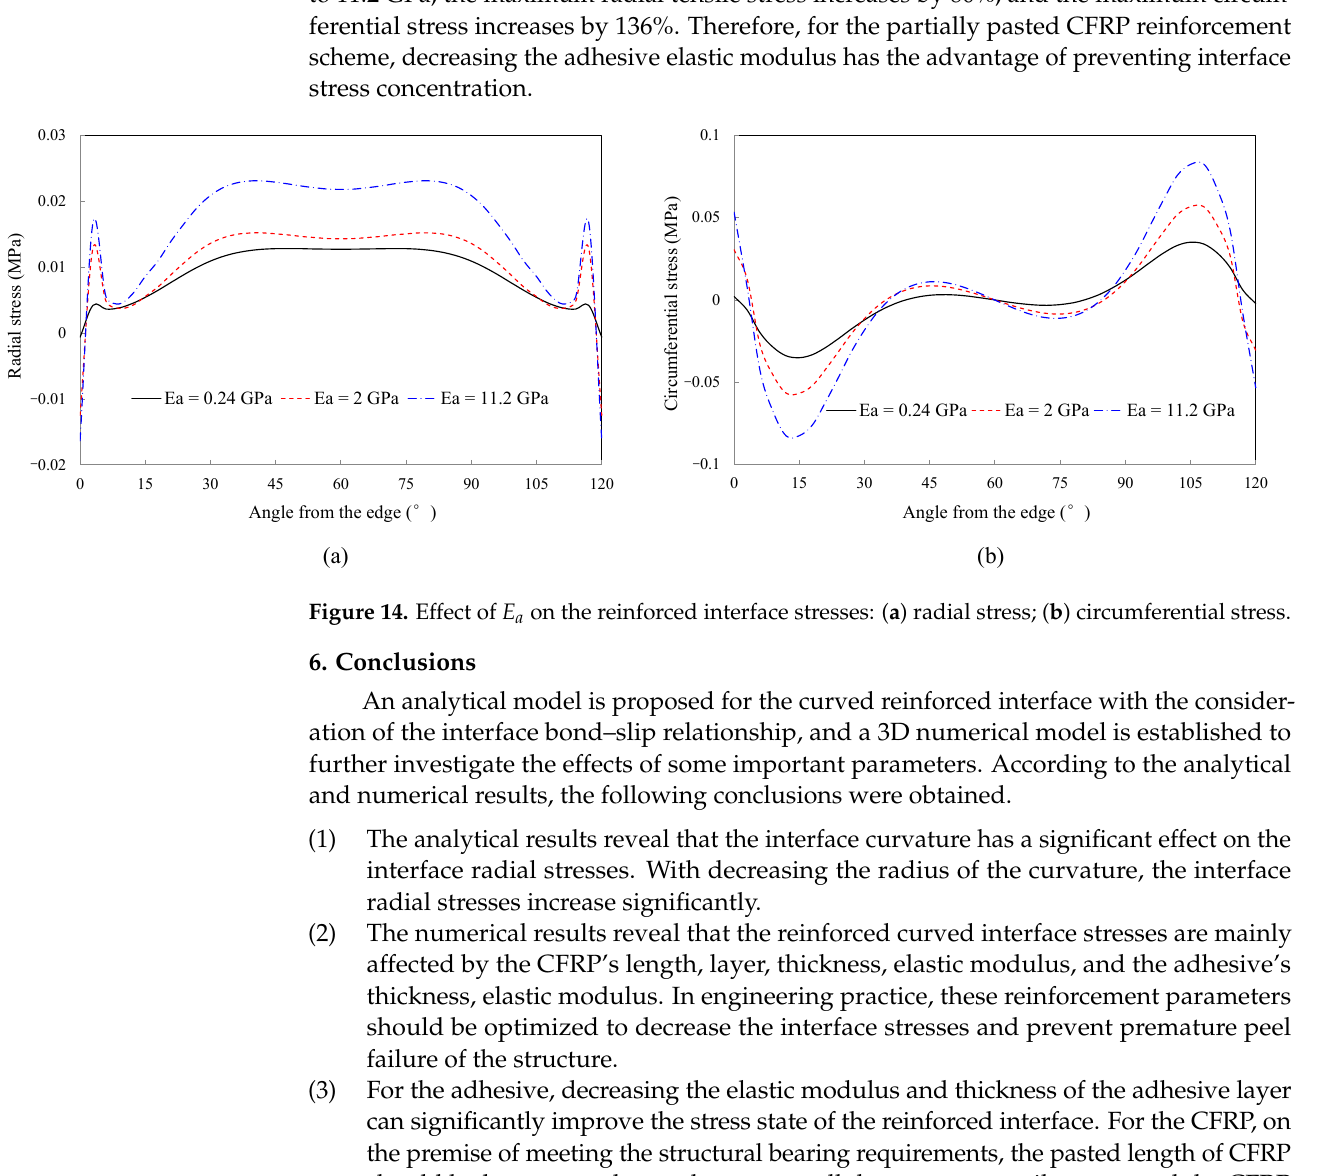
Figure 13. Effect of t a on the reinforced interface stresses: ( a ) radial stress; ( b ) circumferential stress.